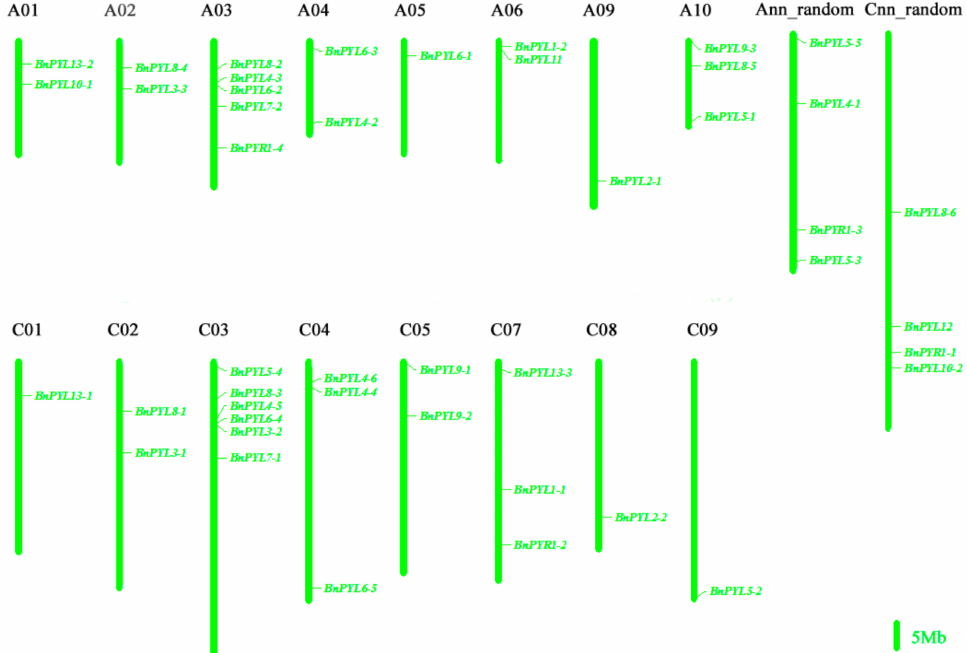
Figure 1. BnPYL distributions on B. napus chromosomes. The chromosome name is at the top of each bar. Ann_random: unmapped A chromosomes of the B. napus genome; Cnn_random: unmapped C chromosomes of the B. napus genome; the scale of the chromosome is in millions of bases